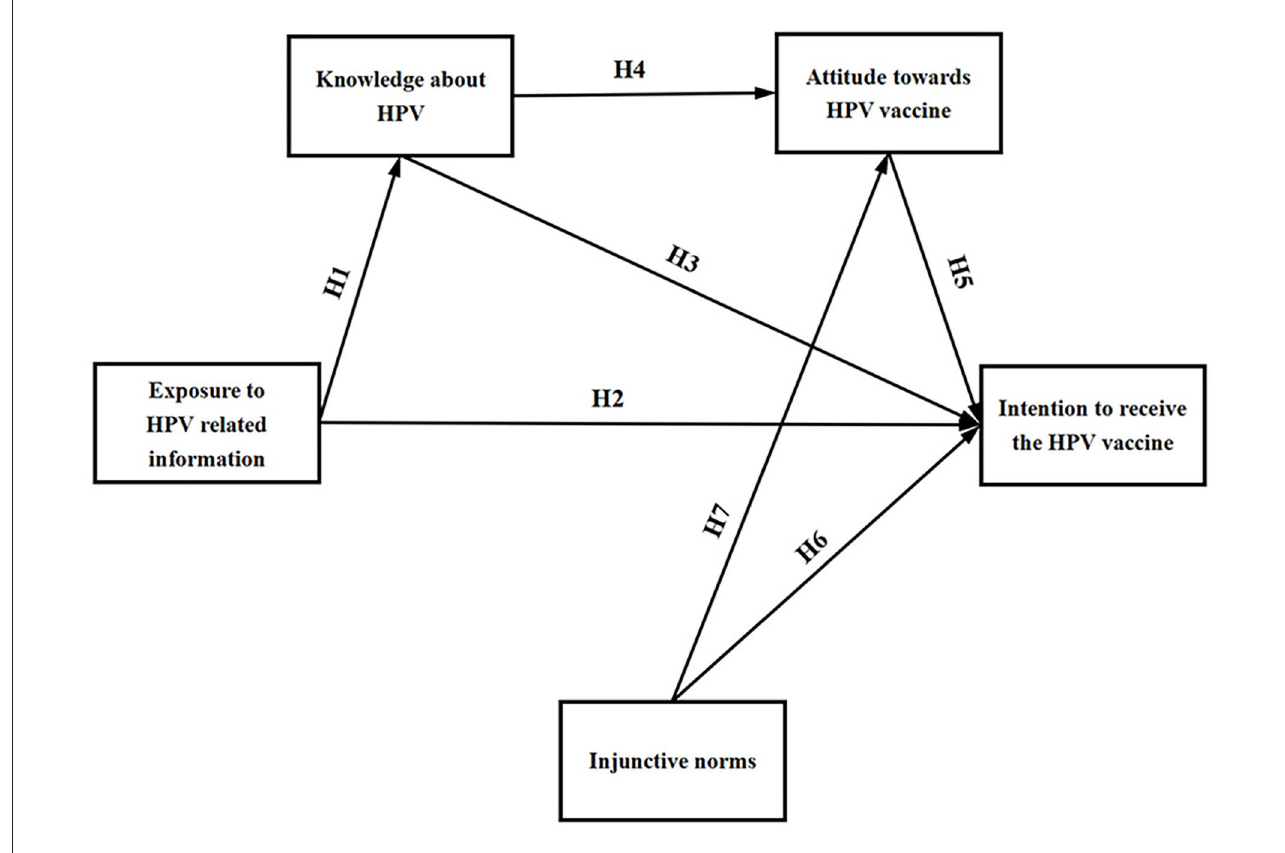
FIGURE1 Research